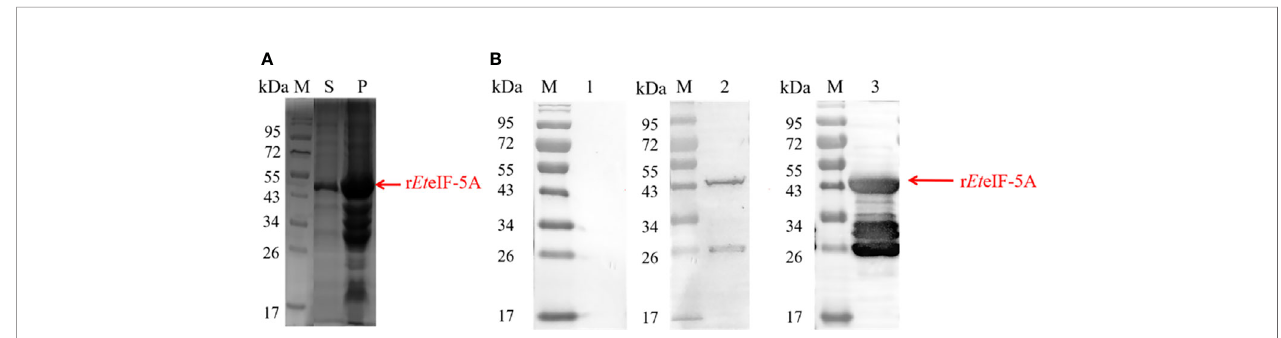
FIGURE 2 | Antigenicity of r Et eIF-5A. (A) SDS-PAGE stained of puri fi ed r Et eIF-5A by coomassie bright blue. (B) Western blot analysis of puri fi ed r Et eIF-5A. Rabbit antiserum against E. tenella sporozoites or monoclonal anti-glutathione S-transferase (GST) antibody was used as the primary antibody. Lane 1, r Et eIF-5A probed with pre-immune rabbit serum. Lane 2, r Et eIF-5A probed with anti-sporozoite rabbit serum. Lane 3, r Et eIF-5A probed with monoclonal anti-GST antibody. S, supernatant; P,